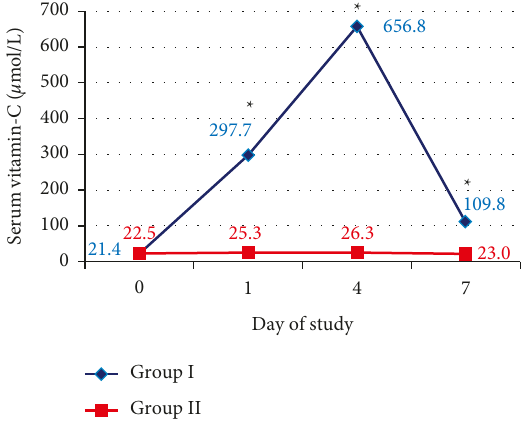
Figure 3: Serum vitamin C levels between the study groups. ∗ Significant.